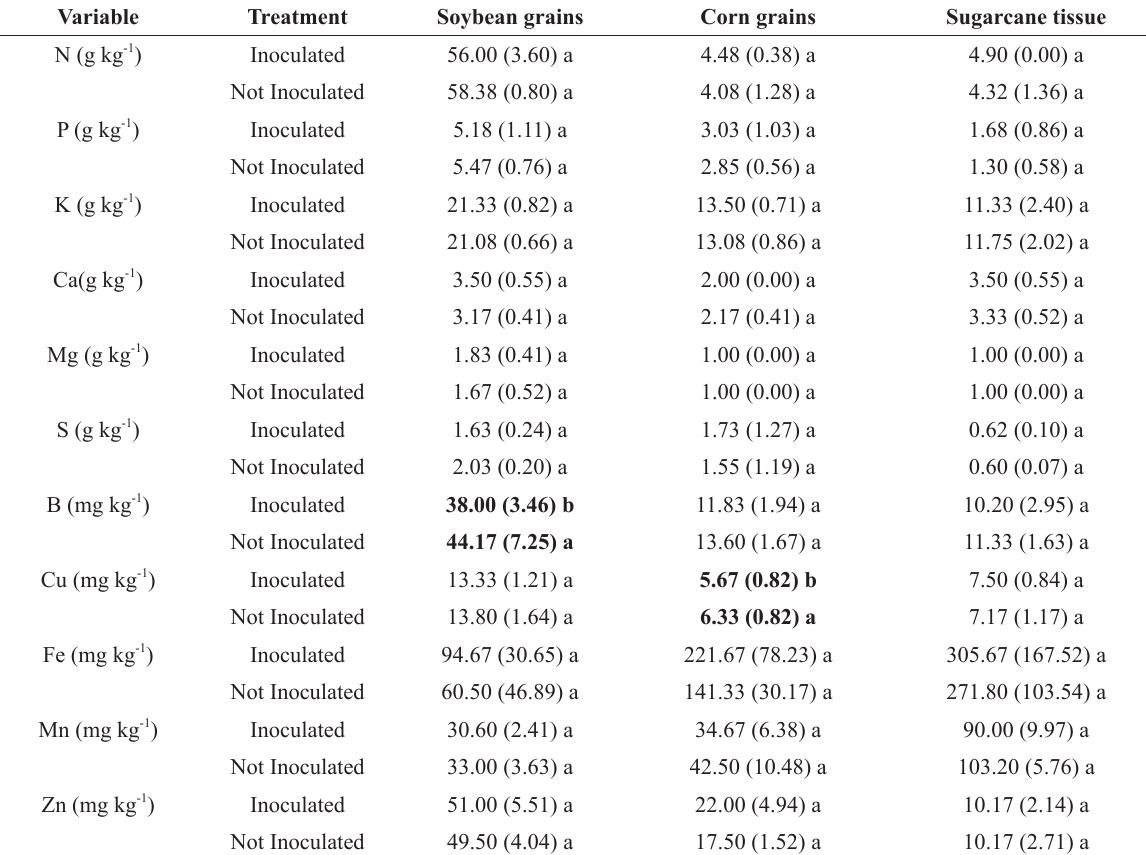
Nutrient contents in leaf tissues of sugarcane and corn and in soybean grains in plants inoculated and uninoculated with the fungal solution composed of the fungi Beauveria bassiana, Metarhizium anisopliae, Pochonia chalamydosporia, Purpureocillium lilacinum , and Trichoderma asperella